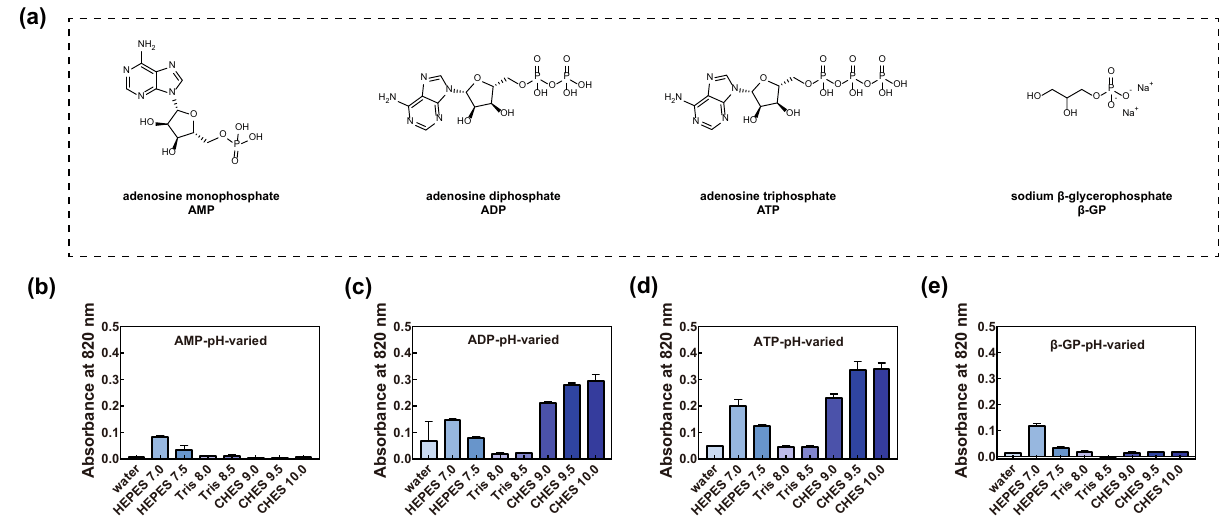
Fig. 3 Phosphatase-like activity of Ce-FMA towards AMP, ADP, ATP and β -GP. a Chemical structures of AMP, ADP, ATP and β -GP. pH-dependent cleaving activity of Ce-FMA-FA-20-RT towards AMP ( b ), ADP ( c ), ATP ( d ) and β -GP ( e ). Experiments were carried out at 37 °C with 1 mM substrate and 0.1 mg/mL Ce-FMA-FA-20-RT for 12 h. Data are processed by removing the blank groups (without catalyst), and presented as the mean ± standard error, n = 4. The conversion rate of 12 h towards AMP, ADP ATP and β -GP under the optimised pH is summarised in Supplementary Table